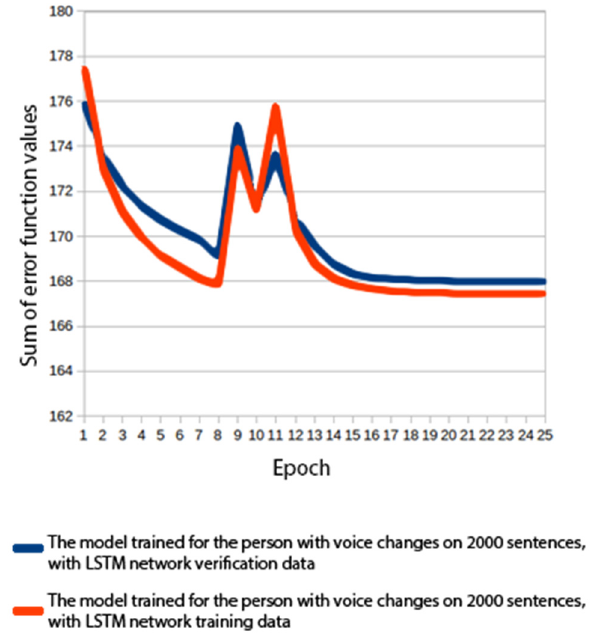
Figure 8. Error function values for a voice trained on 2000 sentences using LSTM layers.